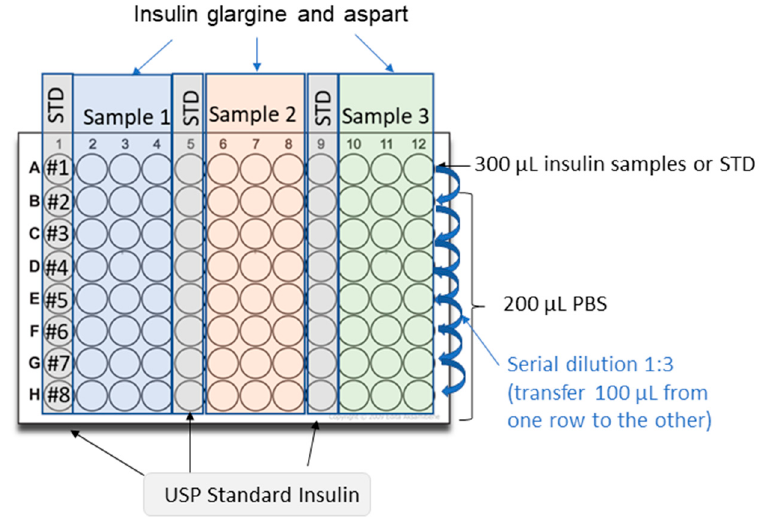
Figure 2. Schematic representation of the preparation of the dilution plates containing insulin glargine or insulin aspart’s standards and samples.